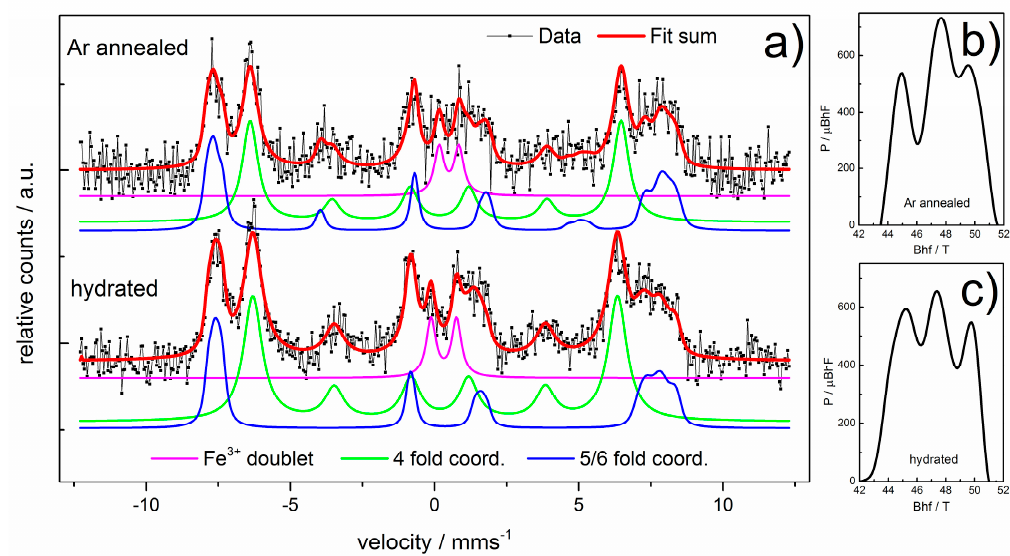
Figure 6. ( a ) CEMS spectra of Ar annealed samples before and after hydration and the corresponding histogram distributions of magnetic hyperfine fields for ( b ) before and ( c ) after hydration.